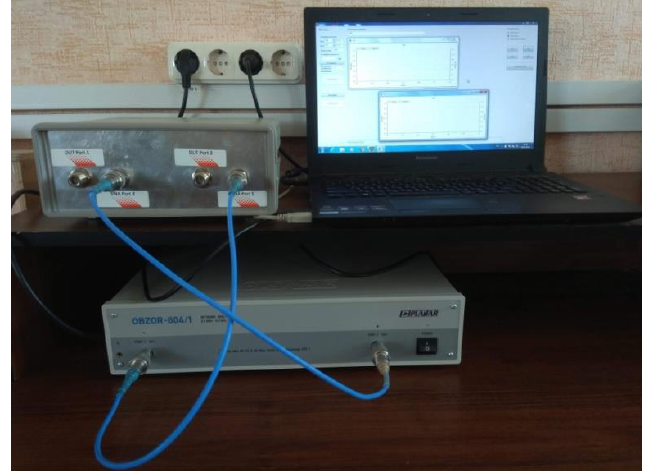
Fig. 3. Appearance of an automated measuring system with a network analyzer Planar -804/1.